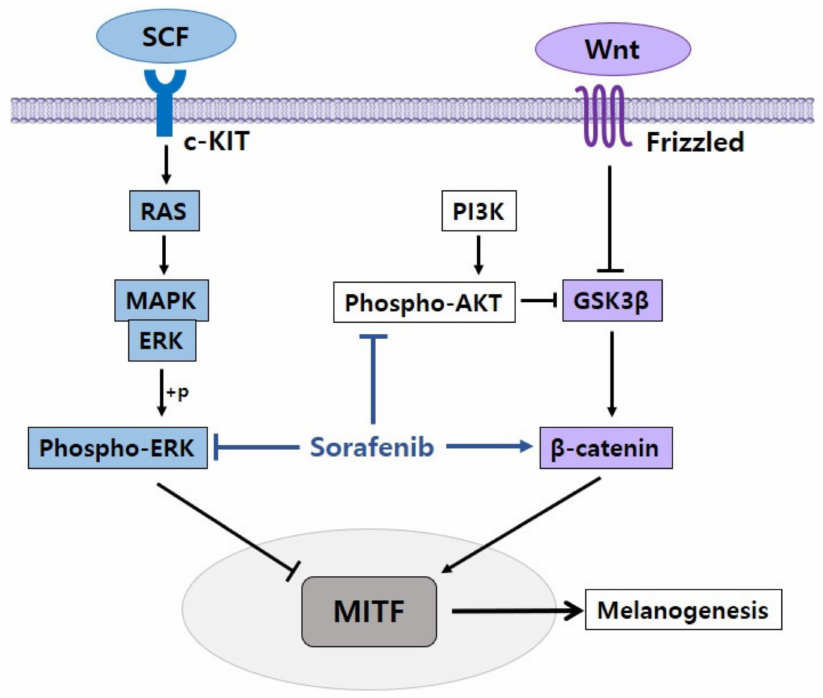
Figure 4. Proposed mechanism of sorafenib in the regulation of pigmentation. Sorafenib enhances melanogenesis by inhibiting phospho-AKT and phospho-ERK and activating β